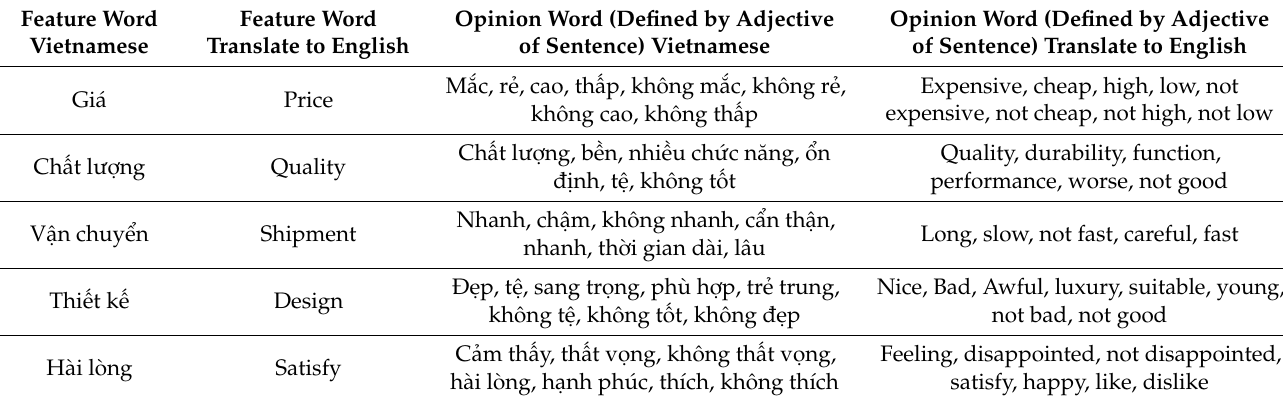
Table 2. Opinion feature word dictionary in